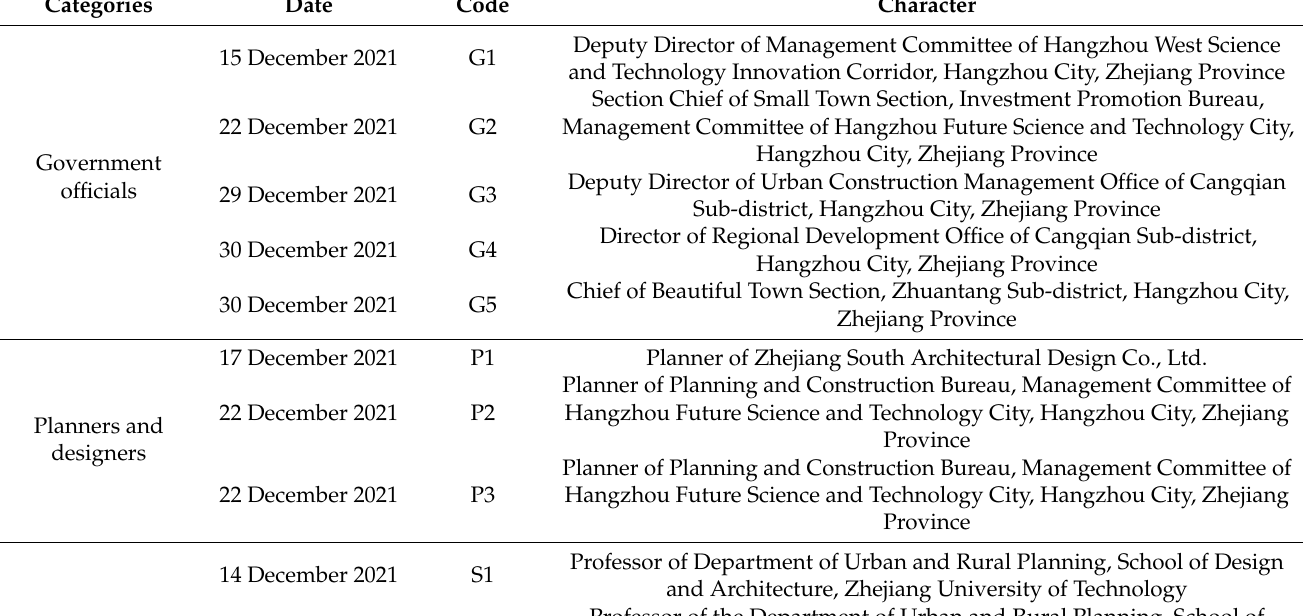
Table 1. List of total interviewees for this paper (source: